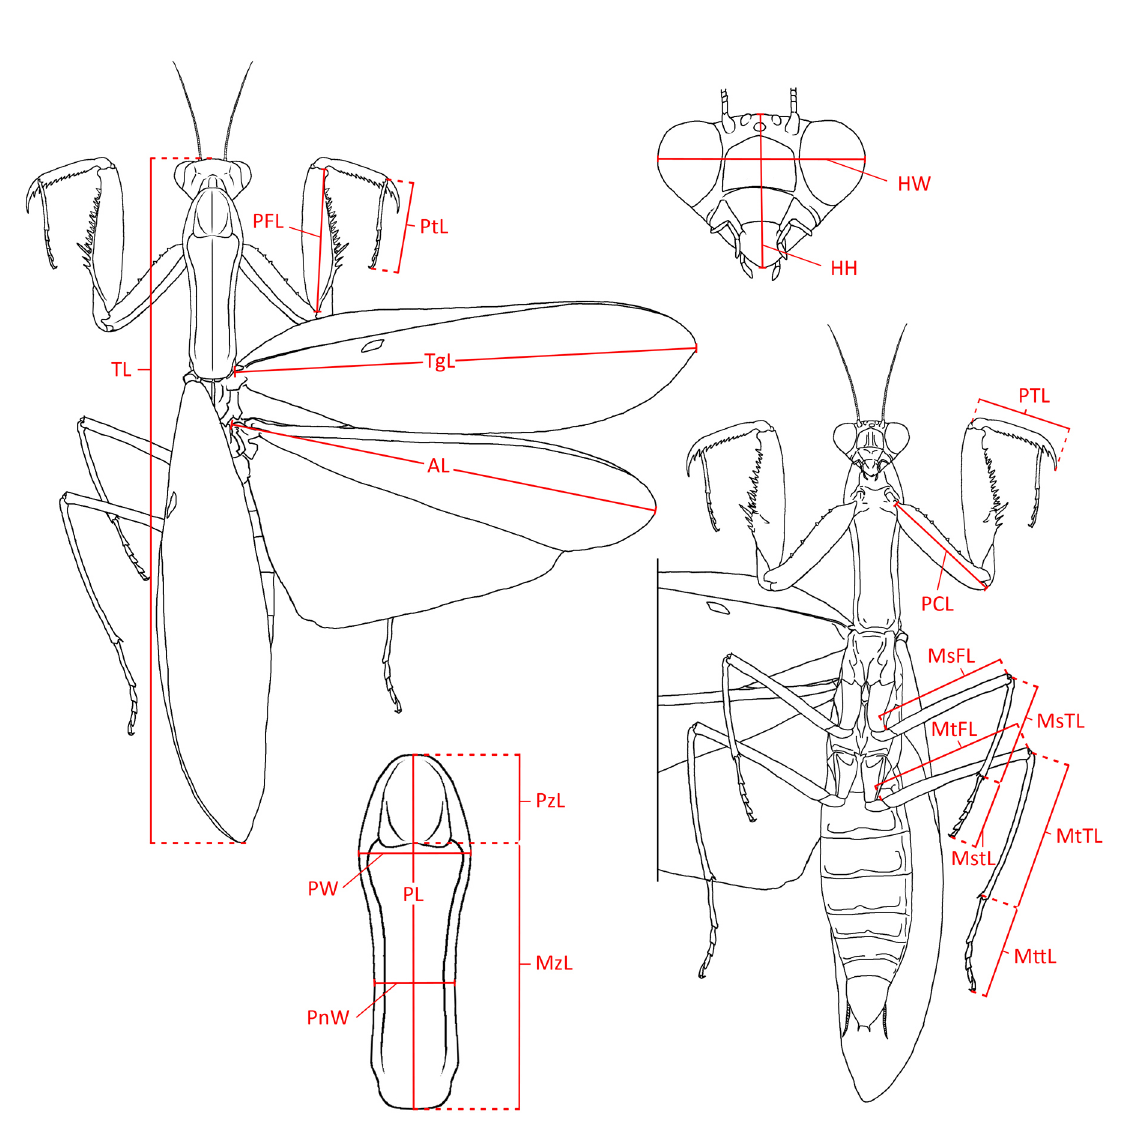
Fig. 1. Overview of the measurements on the habitus of Hierodula spp. Head (top right) : HW = head width; HH = head height. Dorsal view (left) : TL = total length; PFL = profemur length; PtL = protarsus length; TgL = tegmen length; AL = ala length. Ventral view (right) : PTL= protibia length; PCL= procoxa length; MsFL= mesofemur length; MsTL = mesotibia length; MstL = mesotarsus length; MtFL = metafemur length; MtTL = metatibia length; MttL = metatarsus length. Pronotum (bottom left) : PL = pronotum length; PzL = prozone length; MzL = metazone length; PW = pronotum width; PnW = pronotum narrow